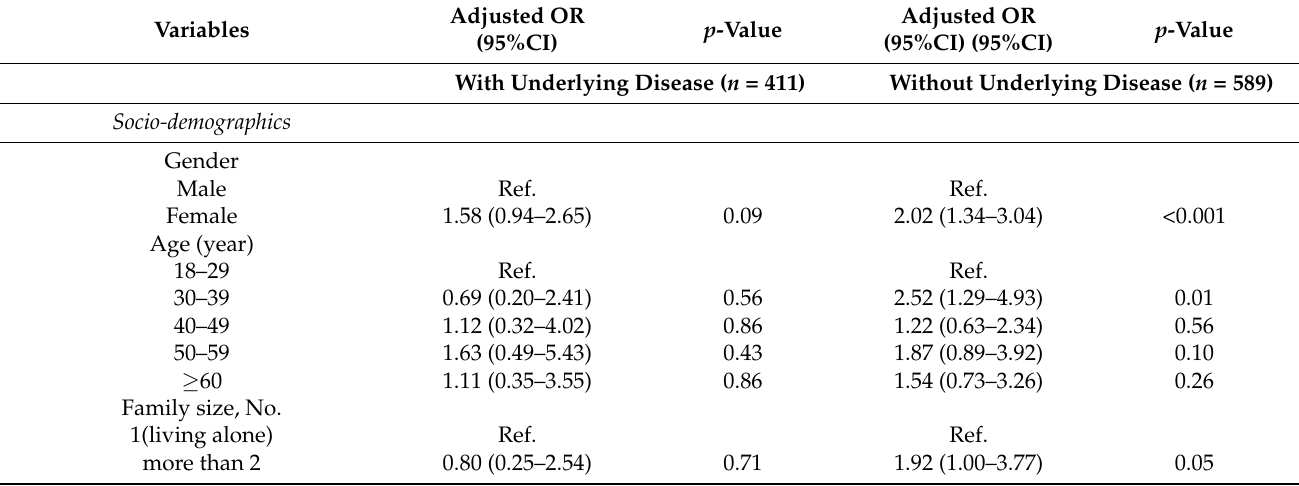
Table 5. Influencing factors associated with the avoidance of healthcare utilization among subgroup participants according to the presence of an underlying